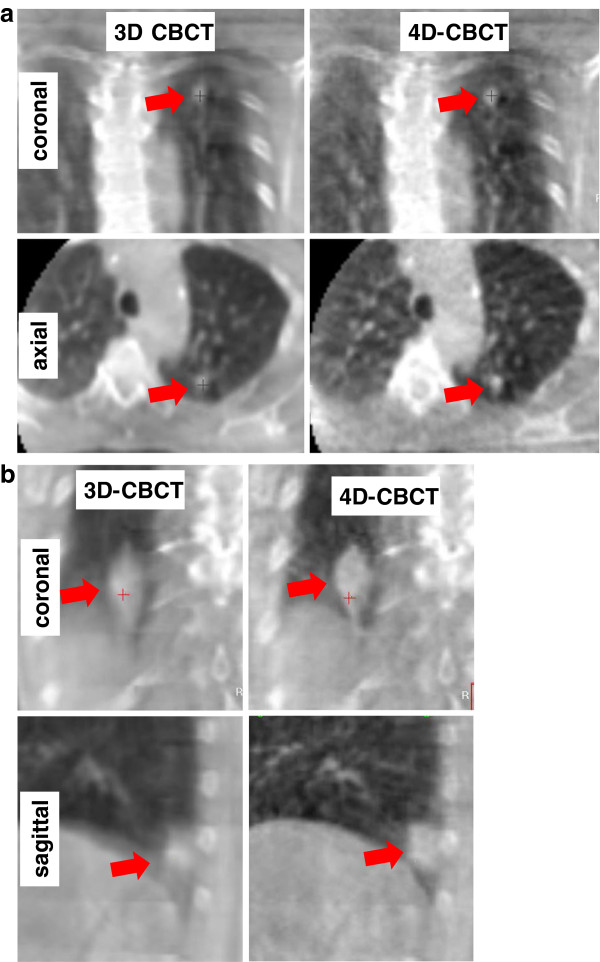
Examples of image quality in 3D-CBCT and 4D-CBCT. The arrow indicates the position of the target. a) Small target in the upper lobe with a 3D motion amplitude of 9.3 mm, where averaged image quality was 3.0 and 1.8 in 3D-CBCT and 4D-CBCT, respectively. b) Target in the lower lobe immediately superior to the diaphragm with a 3D motion amplitude of 16.6 mm, where averaged image quality was 3.0 and 1.3 in 3D-CBCT and 4D-CBCT, respectively.